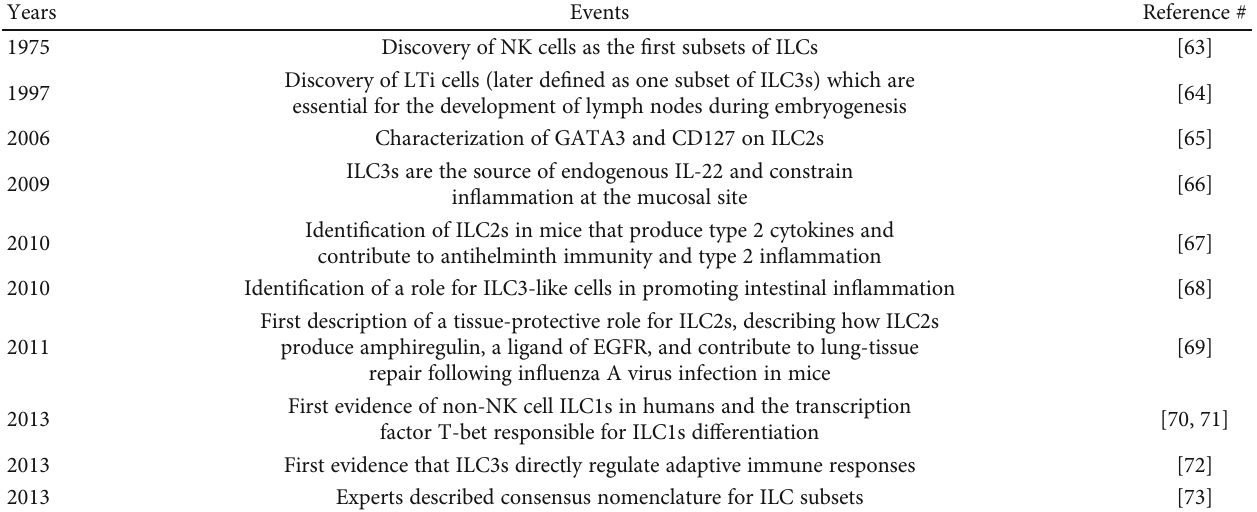
Table 1: List of some important studies in ILC research